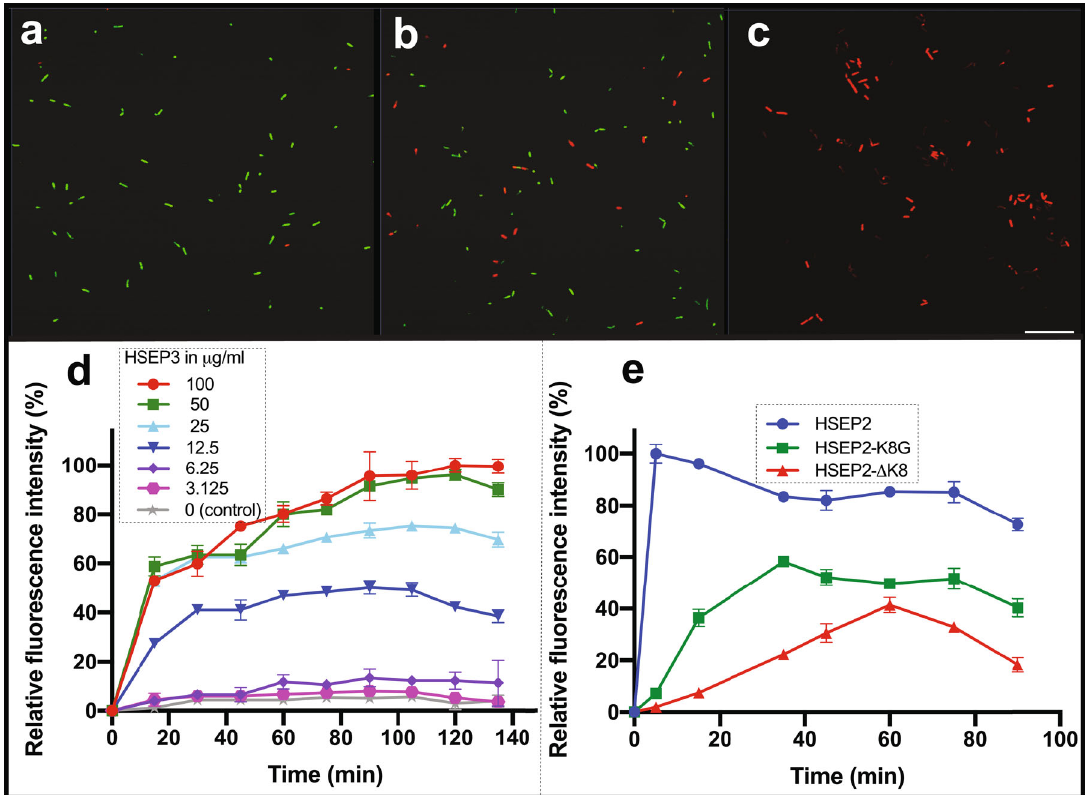
Fig. 4 Membrane permeabilization in B. cereus treated with HSEP3, HSEP2, and HSEP2-mutant peptides. Upper panel: a Control, no peptide; b HSEP3 treated at 0.5X MIC concentration, and c HSEP3 treated at 1X MIC concentration. All three samples treated with Syto-9 (in green, indicating live cells) and propidium iodide (in red, indicating dead cells). d Permeabilization of the cytoplasmic membrane of B. cereus as a function of HSEP3 peptide concentrations (0 – 100 μ g/mL), calculated as percent of propidium iodide fl uorescence. e Permeabilization of the cytoplasmic membrane of B. cereus by HSEP2, HSEP2-K8G, and HSEP2- Δ K8 (2X MIC), indicated by percent of propidium iodide fl uorescence. Data represent mean ± s.e.m. of three biological replicates. Scale bar denotes 25.40 μ